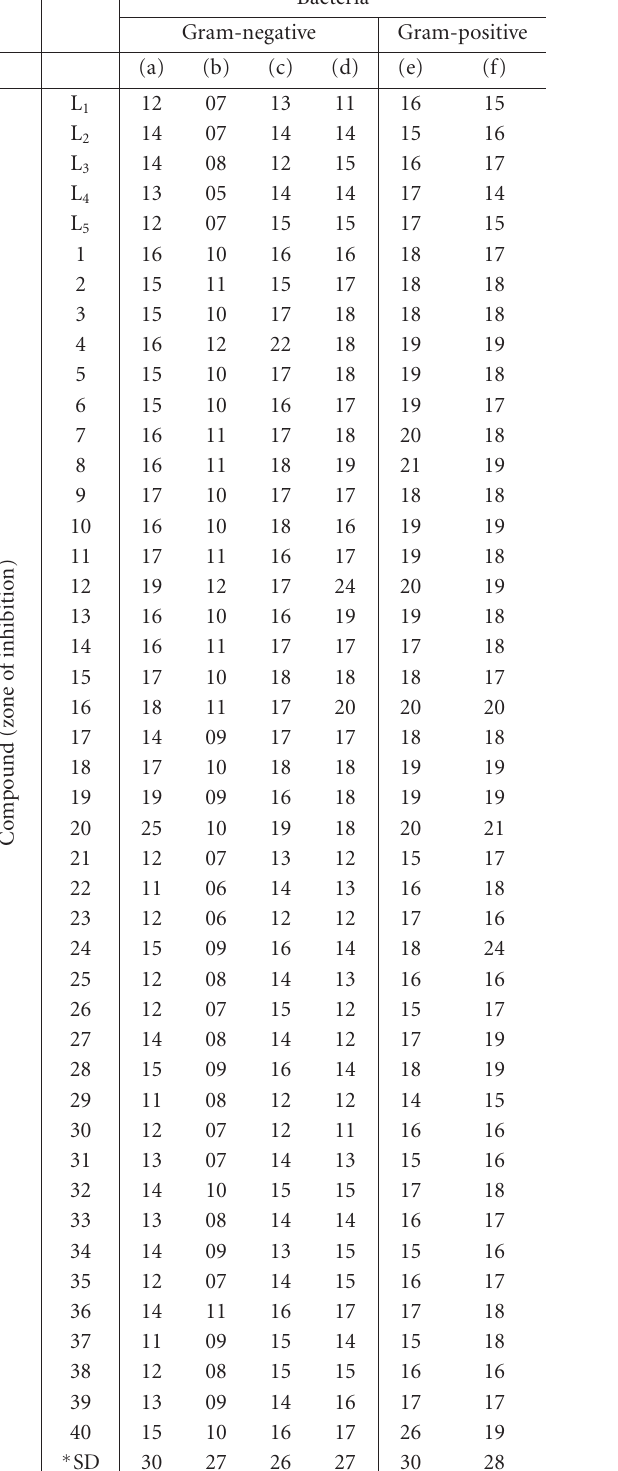
Table 4: Results of antifungal bioassay (concentration